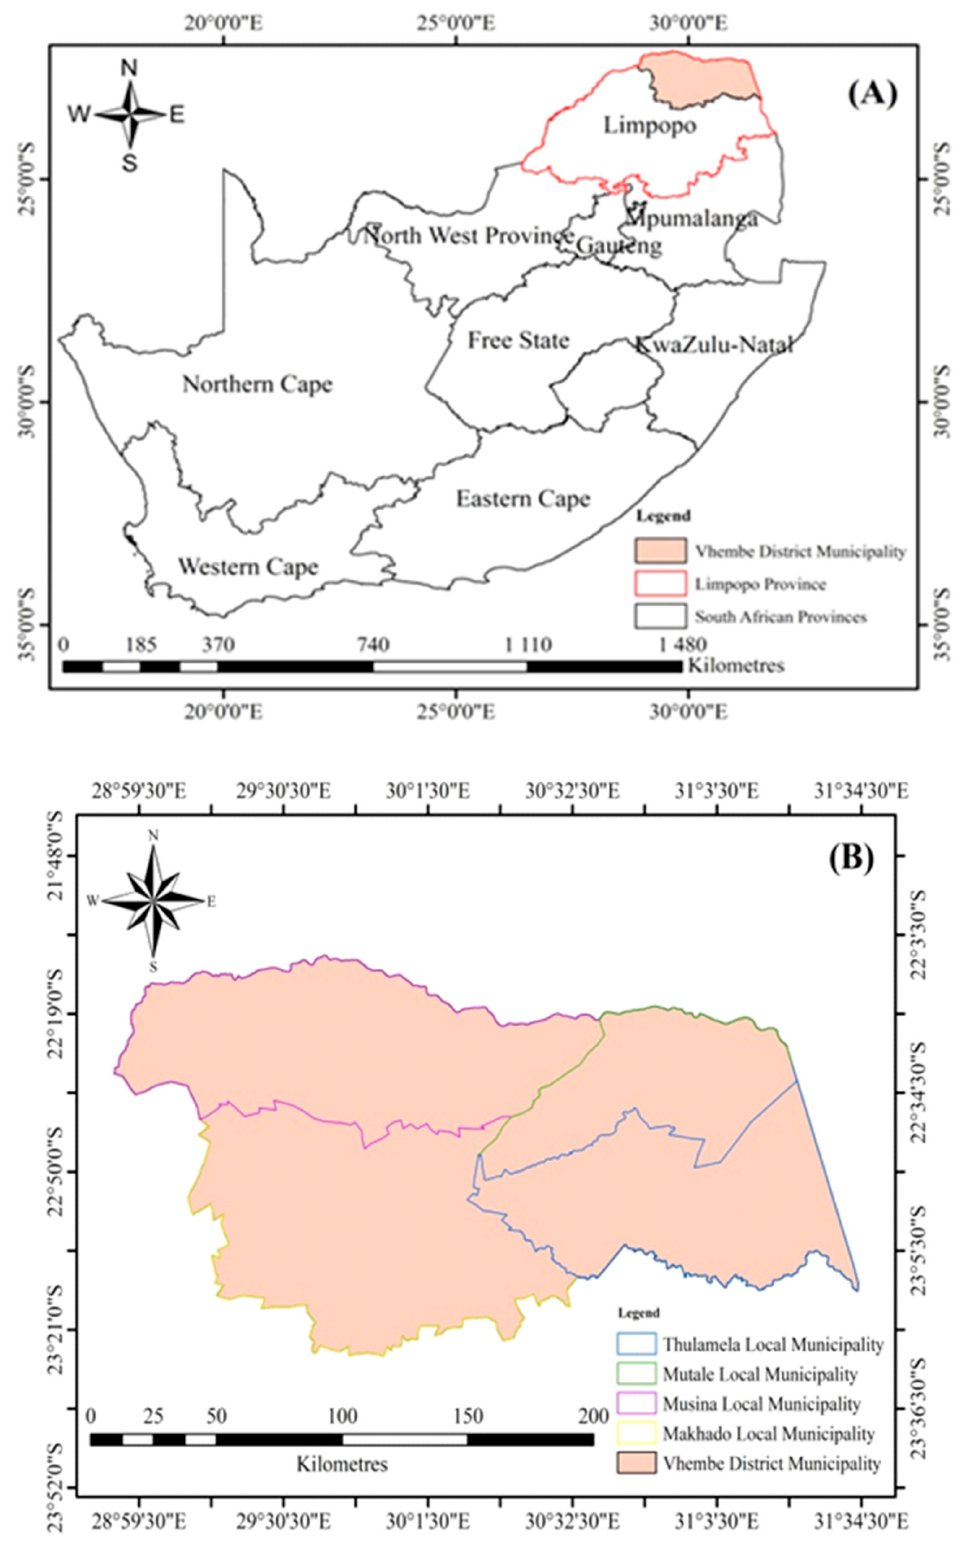
Figure 1. Map showing the location of ( A ) The Republic of South Africa’ provinces and provincial boundaries, highlighting the location of the Limpopo province and the Vhembe district within the Limpopo province of South Africa and ( B ) shows the location of the four local municipalities within the Vhembe district.